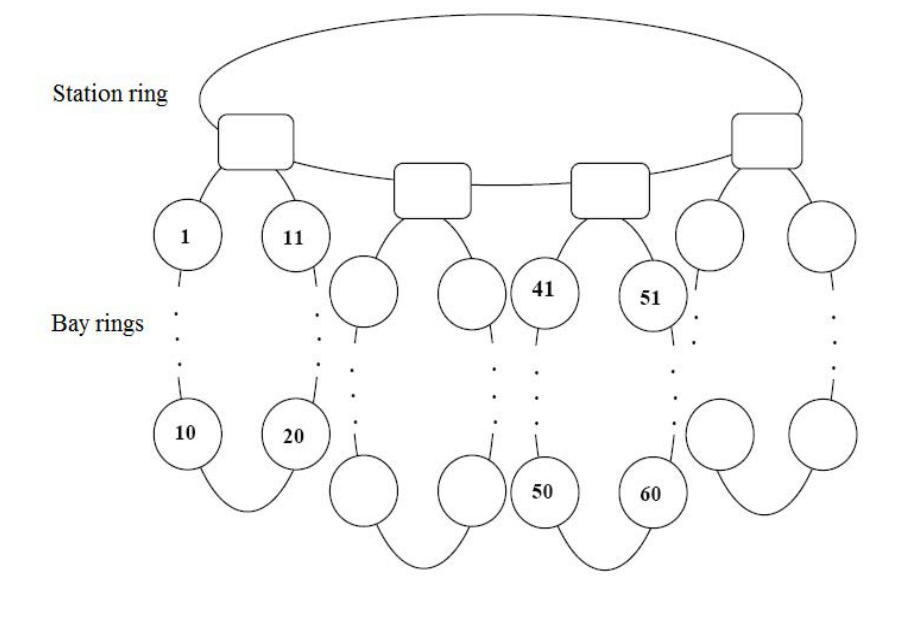
Figure 9. Sample network for the second